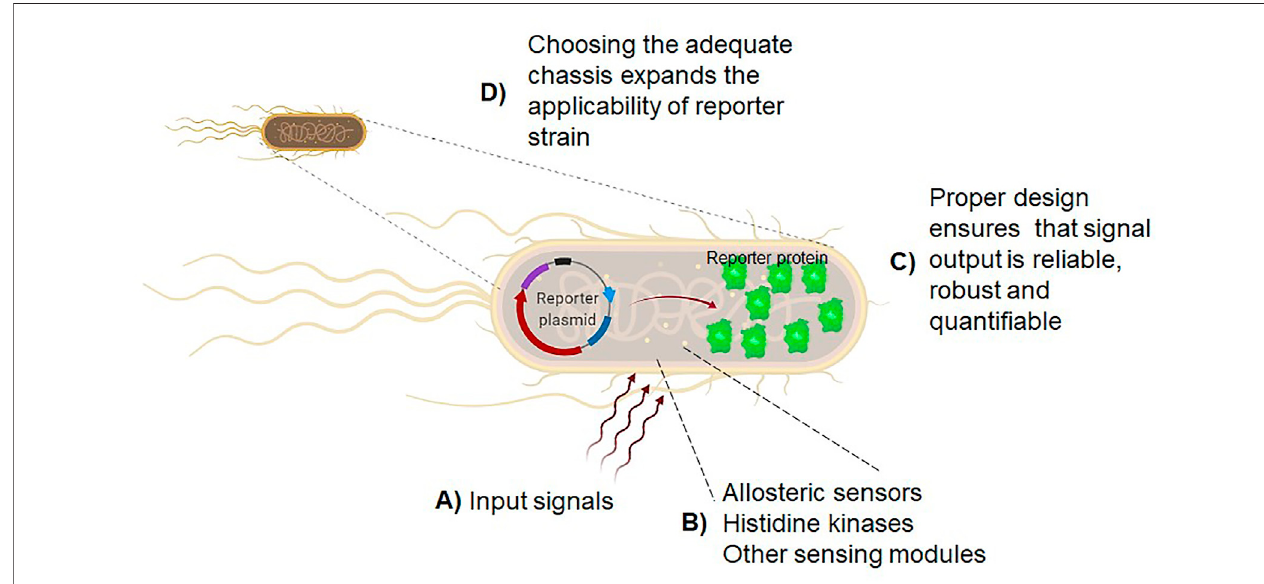
FIGURE 1 | Biosensors using whole cells are versatile and, depending on the chassis, be resilient to severe conditions. The framework for biosensor development includesclearresearchgoals,knowingtheliteratureforassessingthelimitingstepsinametabolicorregulatorypathway,identifyingthebiologicalpartstoberepurposed and their characterization, proof-of-concept checkpoint at laboratory scale, and fi nally, the development stage (Moratti et al.). In (A) , the selection of input signals is the fi rst step to determine the goal of the whole-cell reporter strain. In (B) , as described by Famerling et al. the identi fi cation of allosteric sensors, histidine kinases or other sensing modules is relevant for designing reporter strains. Novel sensing modules can be repurposed with the current knowledge in many culturable or unculturable organisms. In (C) , as described by Wang and Childers, Moratti et al., and Zhang et al., optimizing the design that ensures signal perception and output is speci fi c,sensitive,reliable, and robust. Finally,asreported by Tietze et al., in (D) , theselection ofthe cell chassis and the optimization ofthe regulatoryelementsensures that the biosensor will ful fi ll the optimal characteristics for biosensing technologies in the